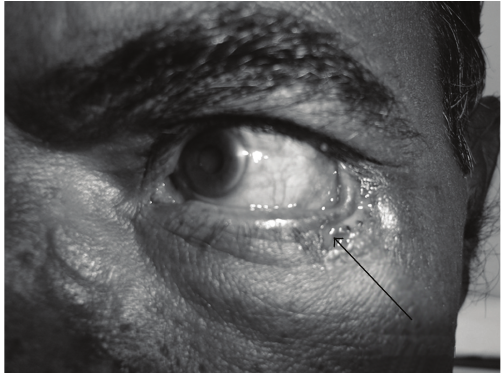
Figure 1: Preoperative picture showing discharging ulcer over left cheek.